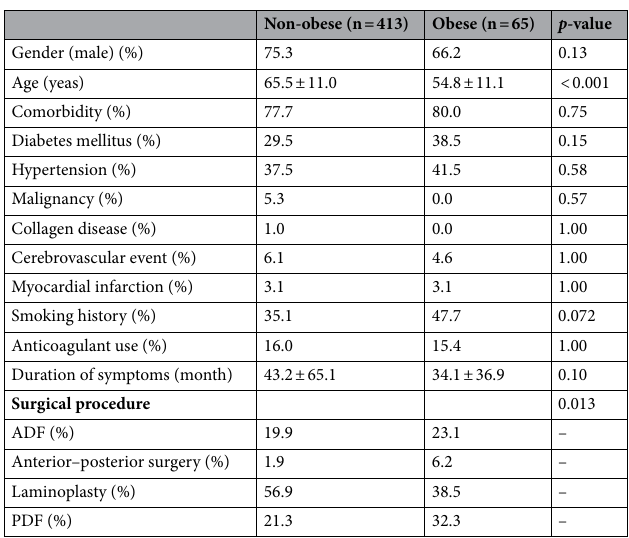
Table 1. Demographics of the participants. Non-obese: BMI < 30.0 kg/m 2 ; Obese: BMI ≥ 30.0 kg/m 2 ; BMI: body mass index; ADF: anterior decompression and fusion; PDF: posterior decompression and fusion. Age and duration of symptoms were represented by mean ± standard deviation.